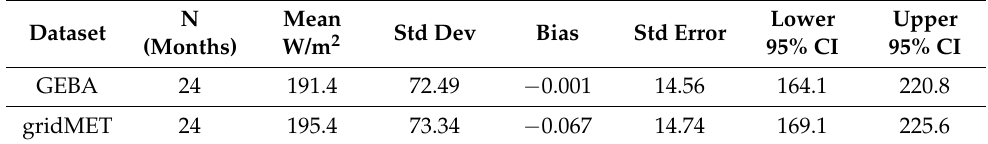
Table 3. Linear regression gridMET vs. GEBA. Bootstrapping N = 1000. GEBA = A*(gridMET) + B. Regression N (Months) Pearson’s r gridMET vs.